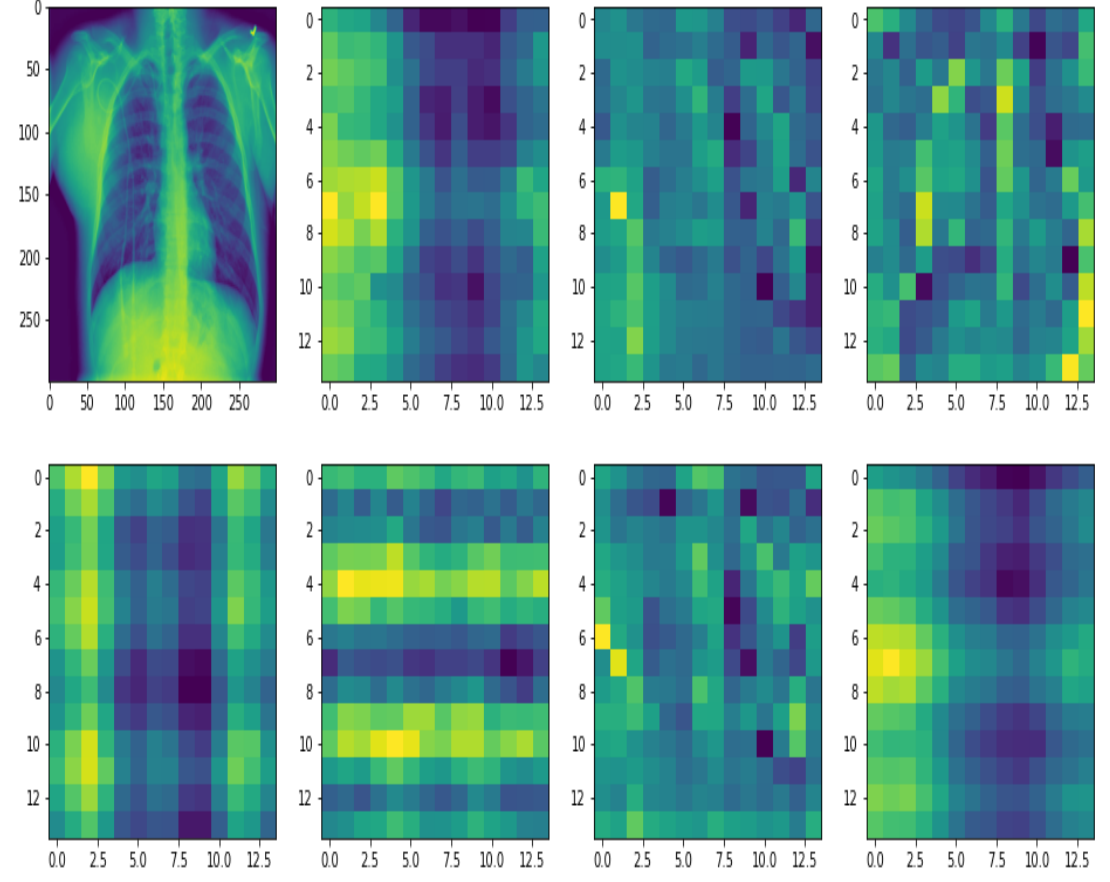
Figure 8. The proposed model focuses on visual features of the input image that are semantic information important for classification.